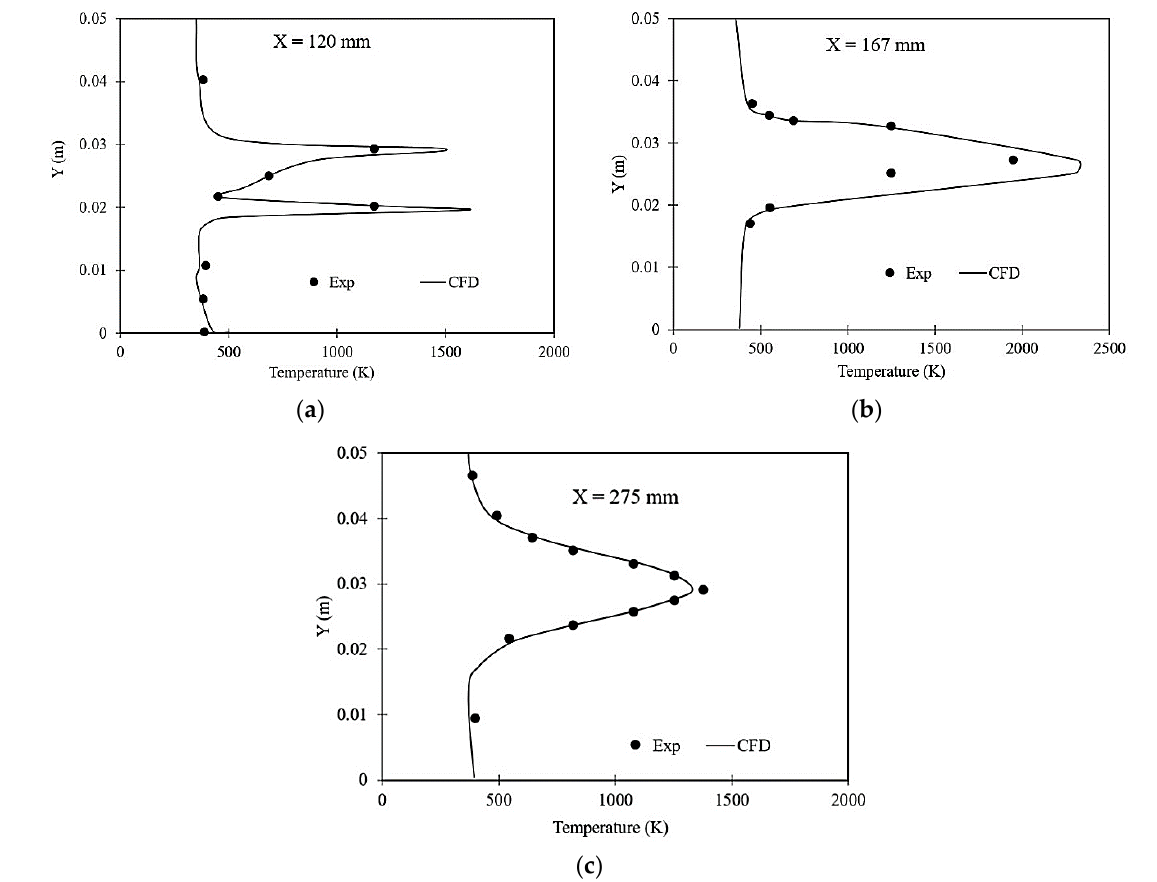
Figure 5. Comparison of numerical simulation with experimental results of static temperature profile across the